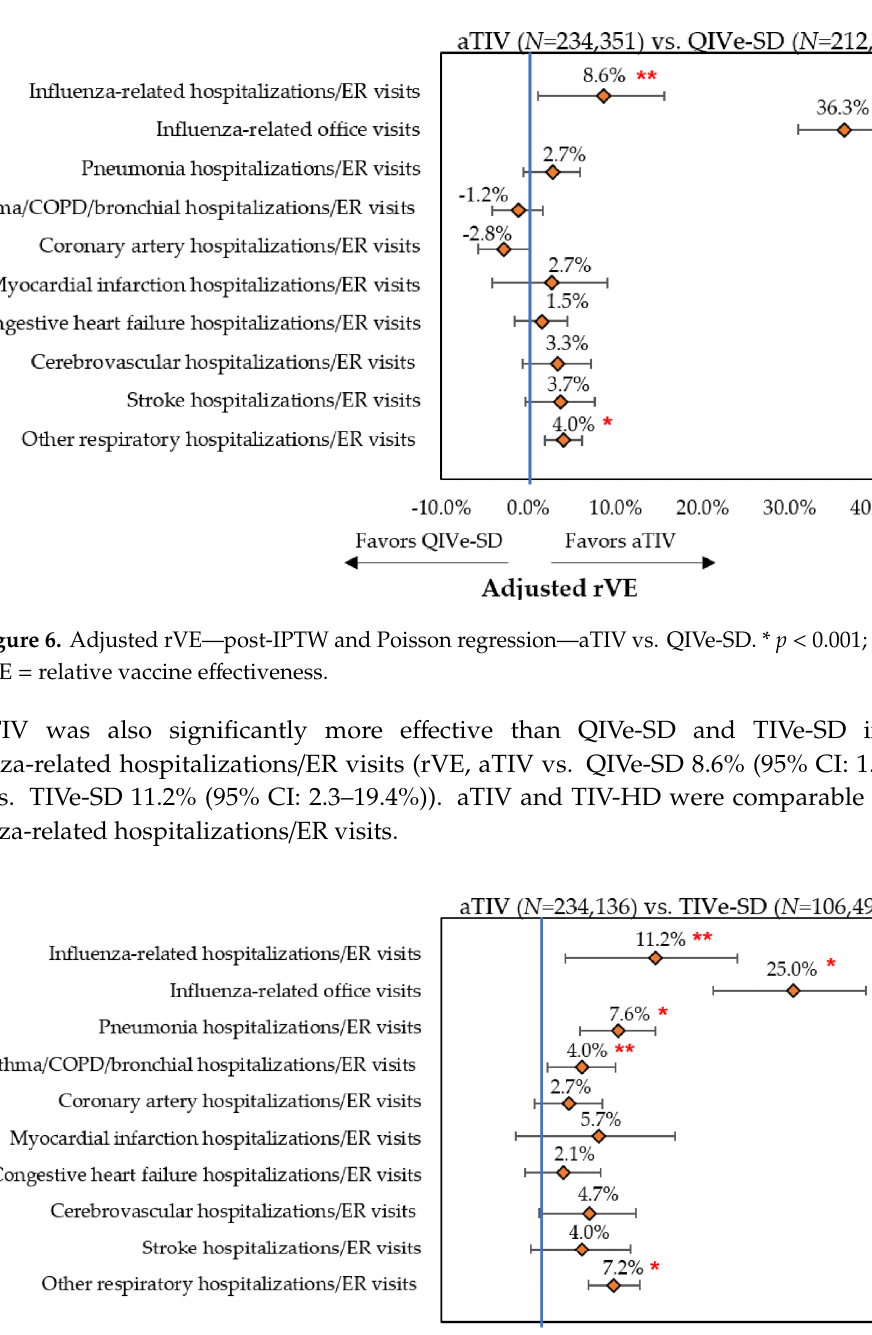
Figure 7. Adjusted rVE — post-IPTW and Poisson regression — aTIV vs. TIVe-SD. * p < 0.001; ** p < 0.05; rVE = relative vaccine effectiveness.